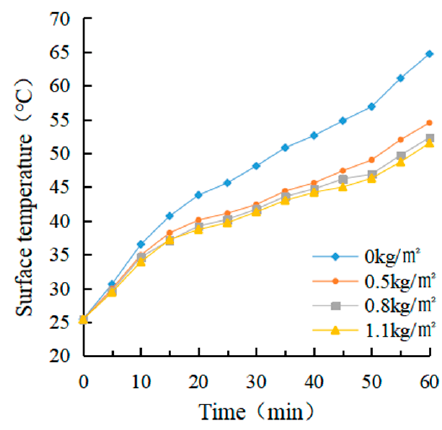
Figure 9. Surface temperature diagram.